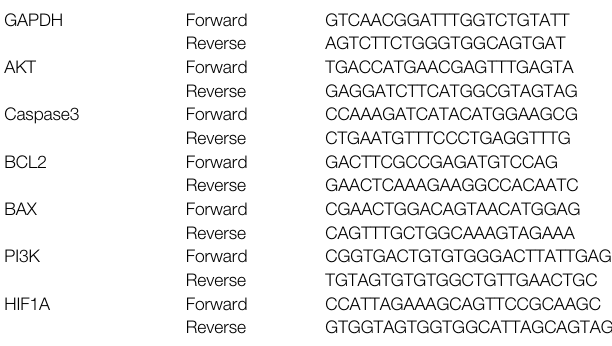
TABLE 1 | Primer pairs for genes detected by real-time